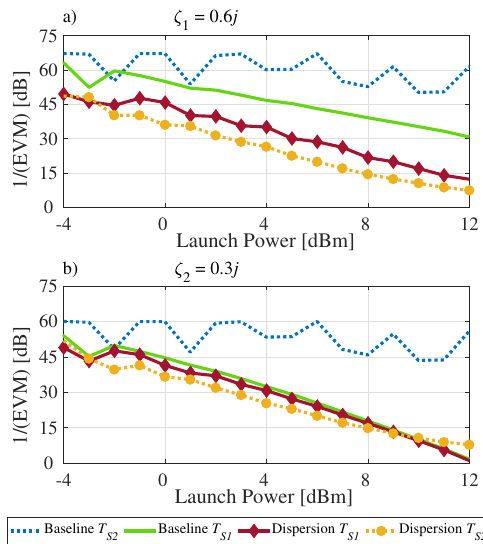
Figure 9. The reciprocal of the EVM as a function of the launch power when only the third-order dispersion is included. ( a ) Results of the signal that is decoded from the first eigenvalue ζ 1 = 0.6 j . ( b ) Results of the signal that is decoded from the second eigenvalue ζ 2 = 0.3 j . Results are shown for the system with a symbol period equal to T S1 and for the system with a symbol period that is equal to T S2 = 2 T S1